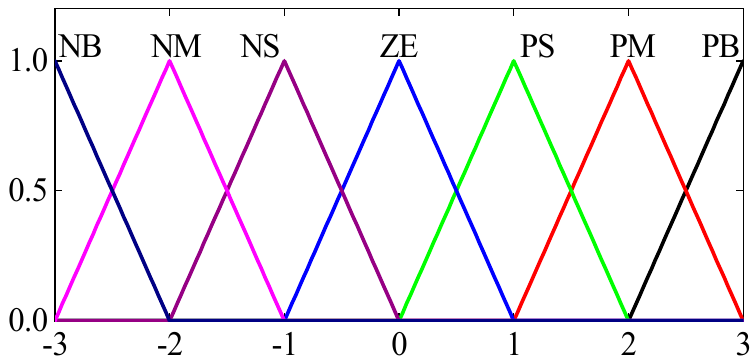
NB (negative big), NM (negative medium), NS (negative small), ZE (zero), PS (positive